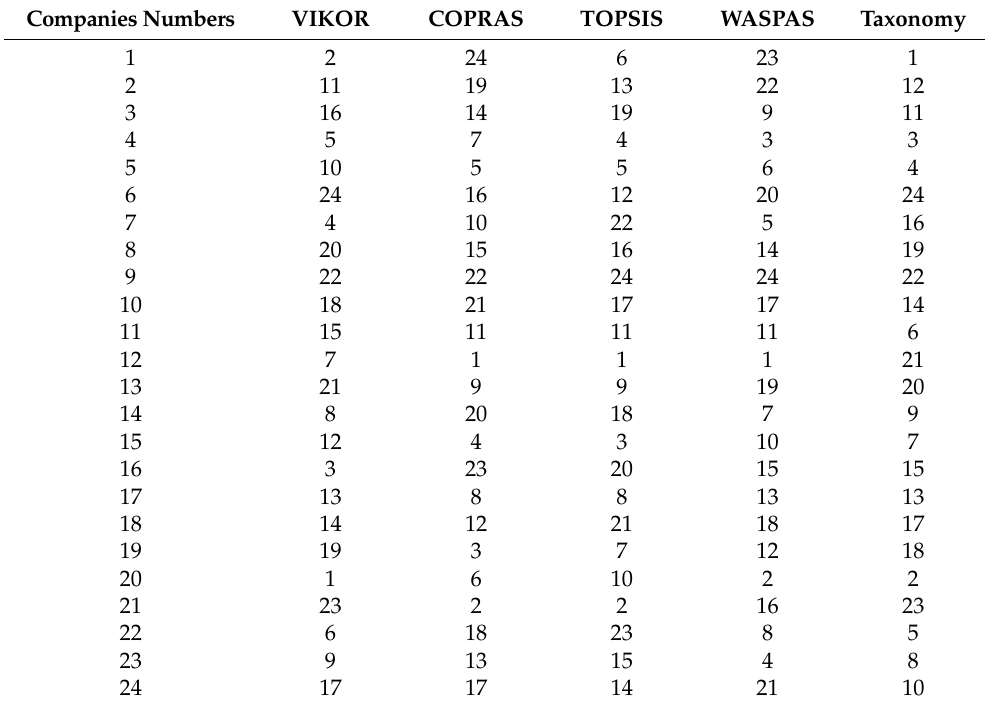
Table 2. Ranking of each company according to fifteen